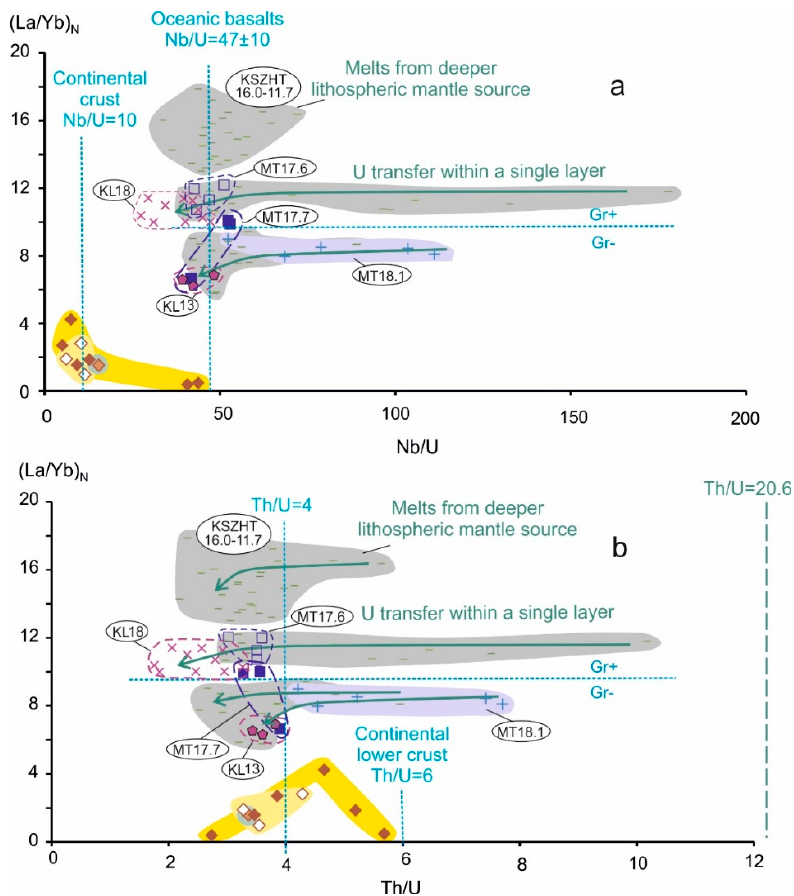
Figure 15. Comparison of basic pseudotachylytes from the MSF and volcanic rocks from the KSZHT on (La/Yb) N -Th/U ( a ) and (La/Yb) N -Nb/U ( b ) diagrams. Symbols are as in Figure 9. Green arrows indicate extraction of U from layers by oxidized fluids that result in decrease of (La/Yb) N due to locally increasing degrees of melting. The upper Th/U limit of 20.6 is shown for a source region from Pb isotope data. (La/Yb) N is calculated using the pyrolite composition after [77].